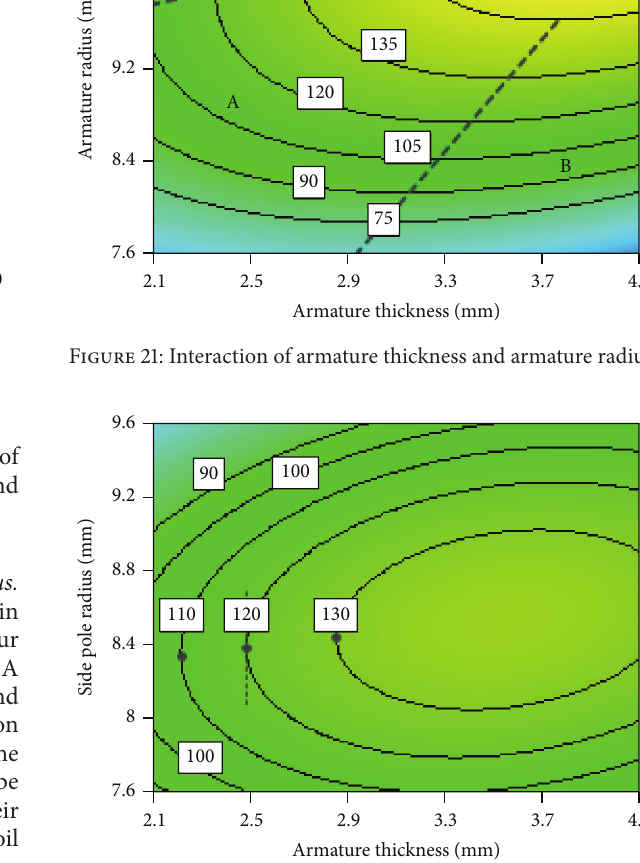
Figure 22: Interaction of armature thickness and side pole